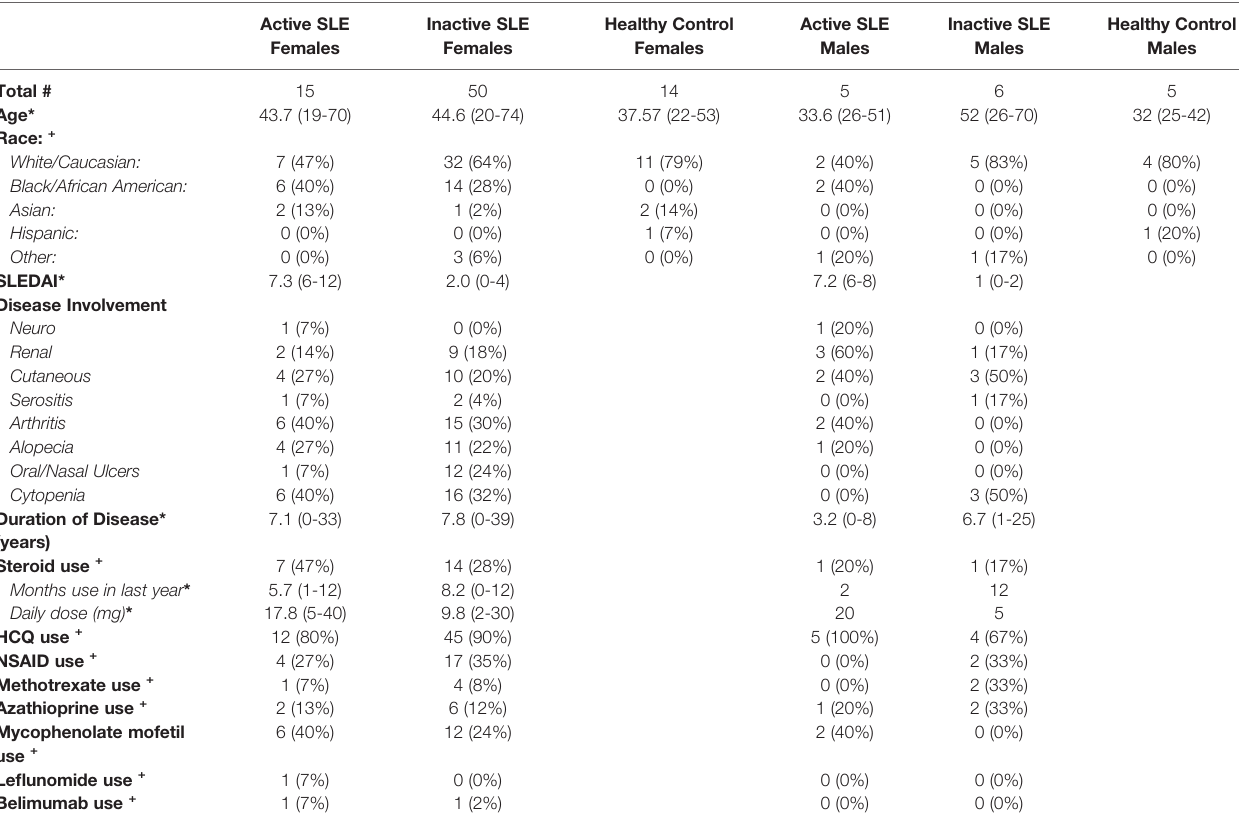
TABLE 1 | Participant